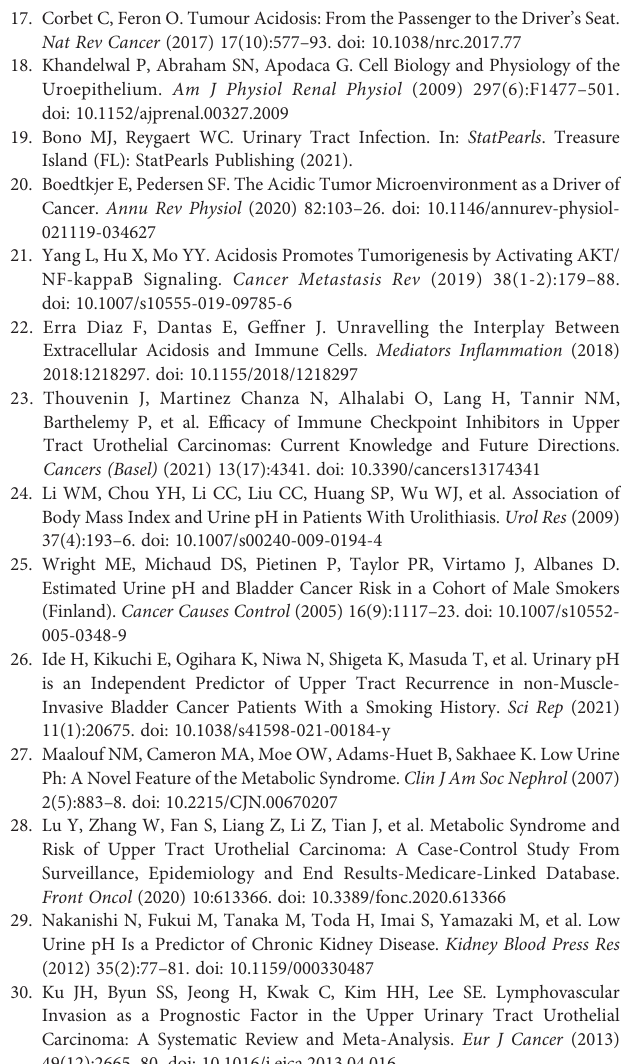
Supplementary Figure1 | Kaplan-Meier curveofthe effect oflow urine pH( ≤ 5.5) (blue) and high urine pH (> 5.5) (dotted green) groups on disease-free survival in patients without a smoking history (A) and patients with a smoking history (B) .